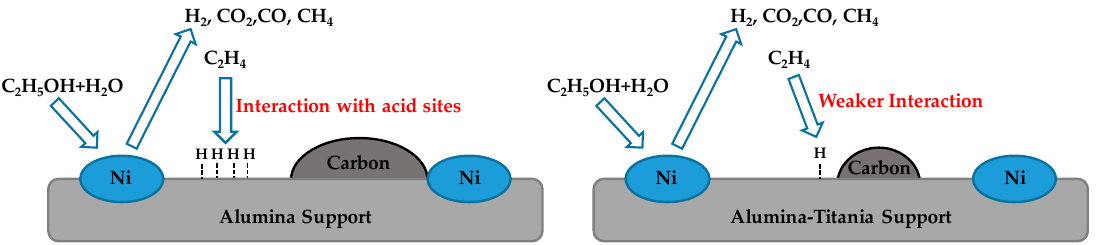
Figure 2. Mechanism of carbon formation of Ni-Al and Ni-Al-Ti catalysts during ethanol steam reforming [52].